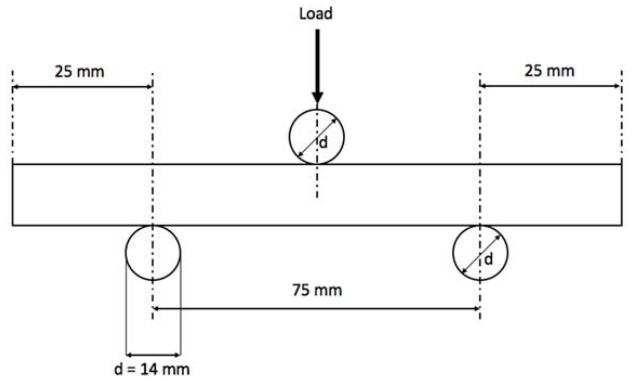
Figure 3. Bending test layout accounting for distances, loading direction and rod diameter (d).